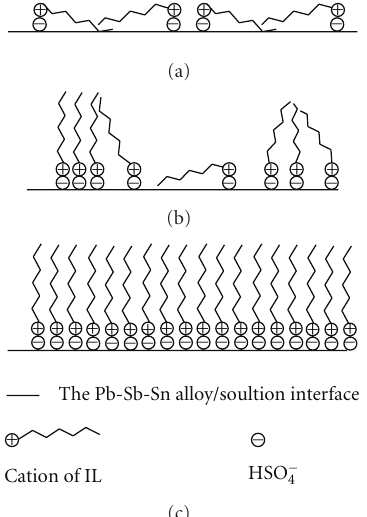
Figure 10: Illustration of adsorption of ILs at lead-antimony/solu- tion interface at constant immersion time (5min). (a) Adsorption as single ILs; (b) hemimicelle formation at some sites of the surface; (c) hemimicelle formation is